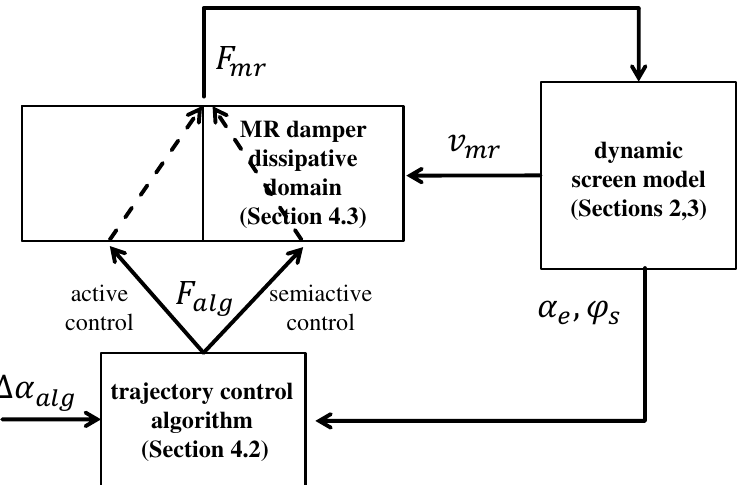
Figure 20. Implemented control block diagram, including the dynamic model of the vibrating screen, the trajectory control algorithm and the MR damper dissipative